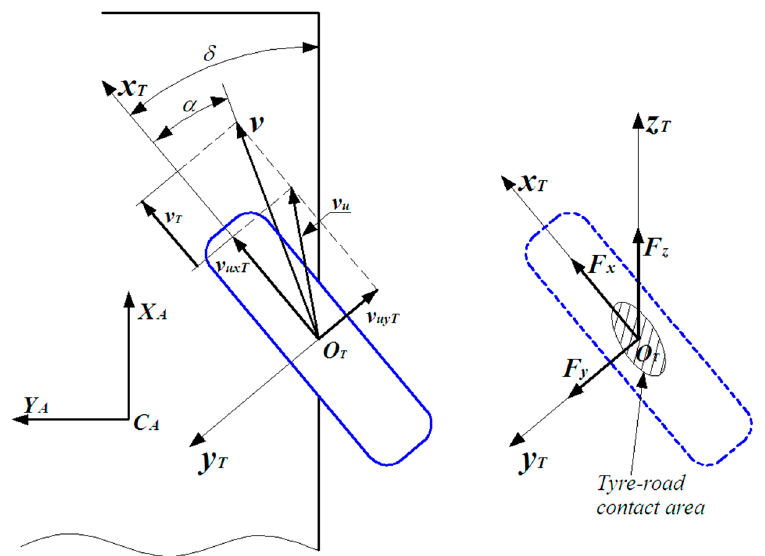
Figure 7. Kinematics and dynamics of the steerable wheel.